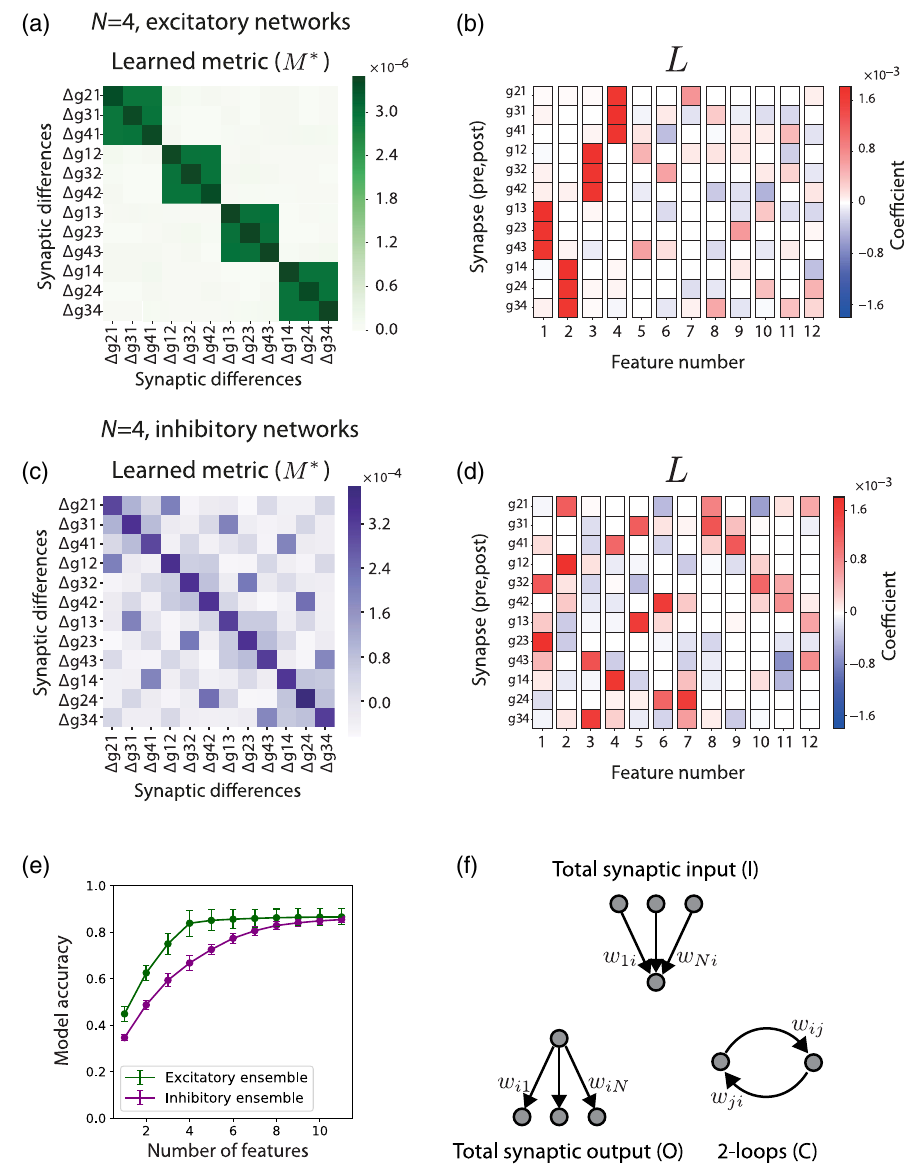
FIG. 3. Identifying the informative structural features that govern the M (cid:3) learned model of network similarity. (a) The optimal Mahalanobis matrix M (cid:3) for networks of N ¼ 4 excitatory neurons. Each entry in the matrix is the weight assigned to a pairwise term in the bilinear function. (b) The sparsest L matrix from Cholesky factor-based decomposition of M (cid:3) from (a). Each column represent a single structural feature. Matrix entries correspond to the weights of the different synapses in each feature. The first four features correspond to the total synaptic inputs to each of the neurons; columns are sorted by their Euclidean norm. (c),(d) The same as (a),(b) but for networks of four inhibitory neurons. Here, loops of length 2 emerge as the dominant structural features. (e) Accuracy of the model when using only the k most important features (ones that have the largest Euclidean norm), for both ensembles of networks of size N ¼ 4 (error bars represent standard deviations over different stimuli). Accuracy is defined as the Pearson correlation between the model ’ s prediction and D . (f) An illustration of the most informative types of structural func